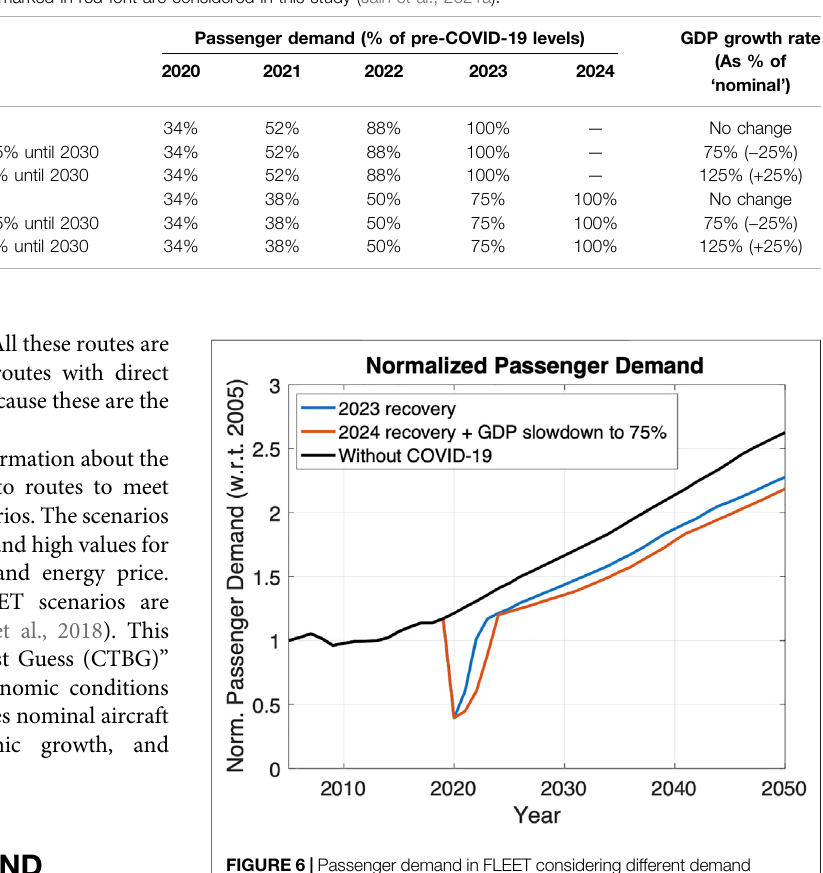
FIGURE 6 | Passenger demand in FLEET considering different demand recovery